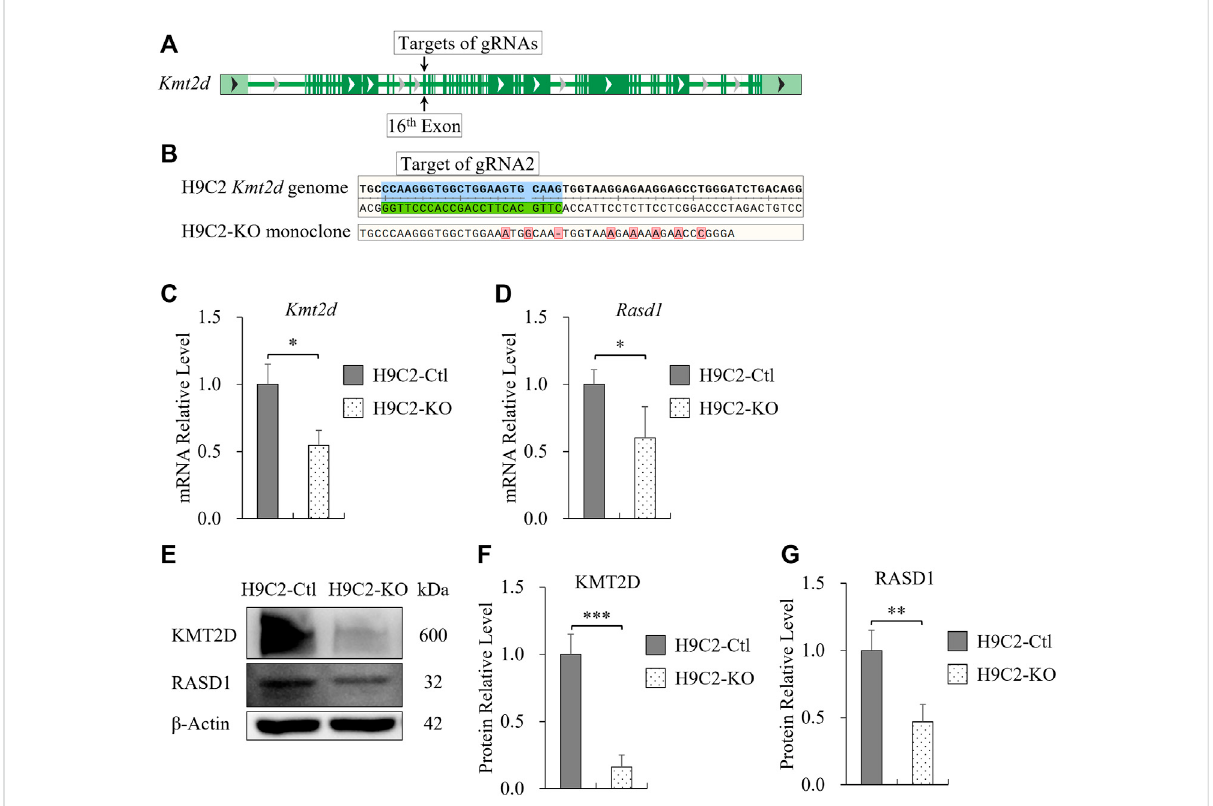
FIGURE 4 Transcription of Rasd1 was weakened in the Monoclonal H9C2 cell line with deletion of KMT2D. (A) Schematic diagram showing targets of gRNAs on the 16th exon of Kmt2d gene in H9C2 cell. (B) Sanger sequencing of genomic DNA from CRISPR/Cas9-edited H9C2 monoclone. (C,D) qPCR analysis of Kmt2d (C) and Rasd1 (D) expression in the H9C2-Ctl and the H9C2-KO monoclone. (E) Representative images of western blots for KMT2DandRASD1,showingexpressionintheH9C2-CtlandtheH9C2-KOcells. (F) QuantitativeanalysisofKMT2DexpressionintheH9C2-KO and the H9C2-Ctl monoclone. (G) Quantitative analysis of RASD1 expression in the H9C2-Ctl cell and the H9C2-KO monoclone. ( n = 3 of each group; * p < 0.05, ** p < 0.01, *** p <